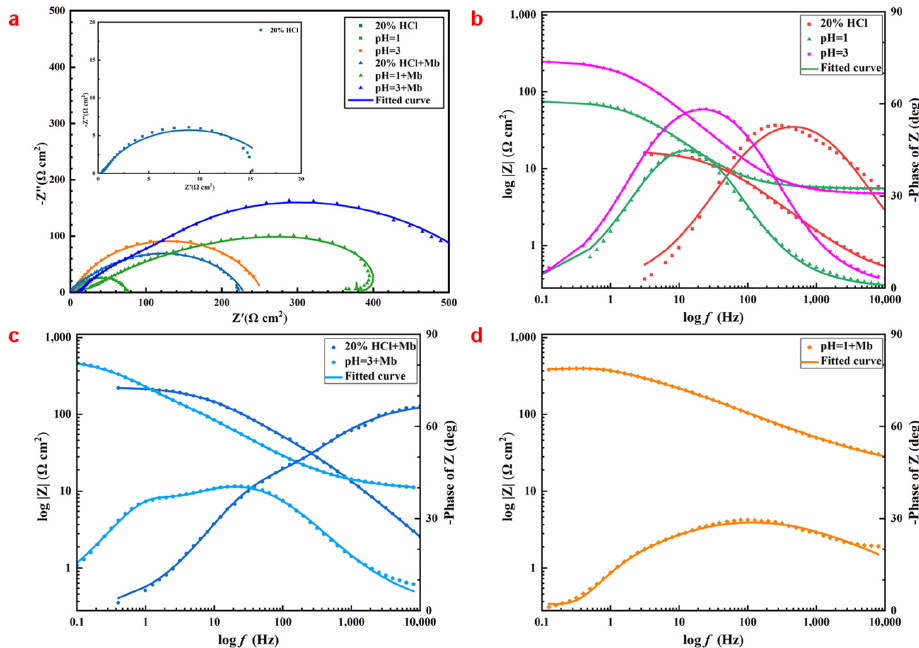
Figure 4. EIS of casing steel immersed in fresh and residual acid solutions with or without Mb inhibitor for 4 h at 90 °C. ( a ) Nyquist diagram; ( b – d ) Bode diagram.